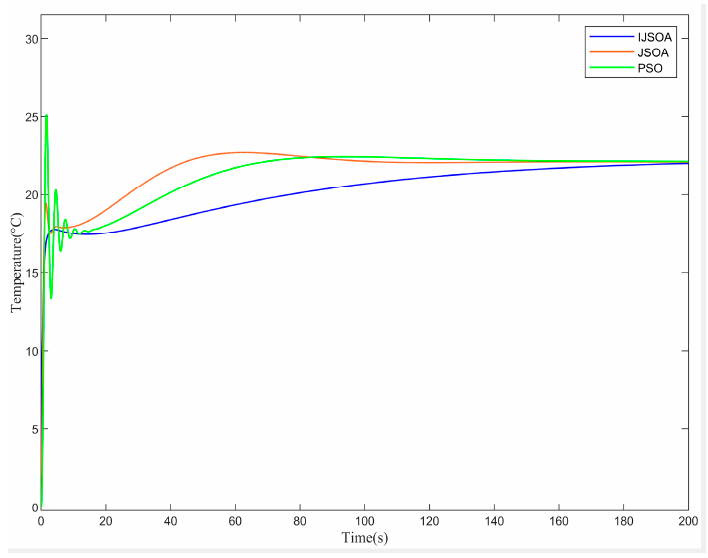
Figure 11. Comparison of temperature control effect.